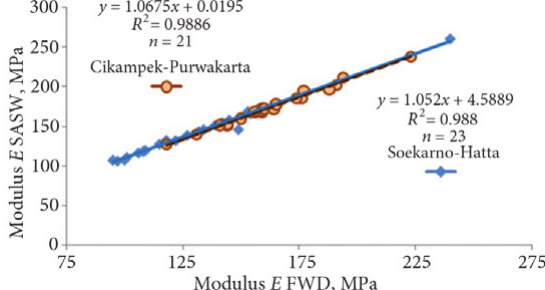
fig. 8. Correlation of elastic modulus of subgrade by SASW method and FWD test for the Soekarno-Hatta and Cikampek-